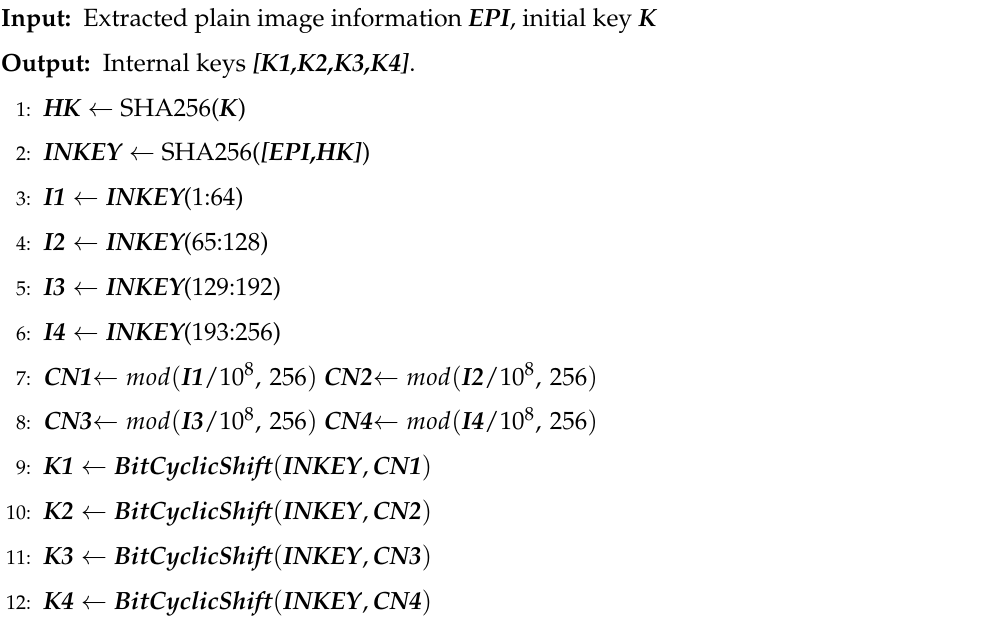
Algorithm 2 Internal keys